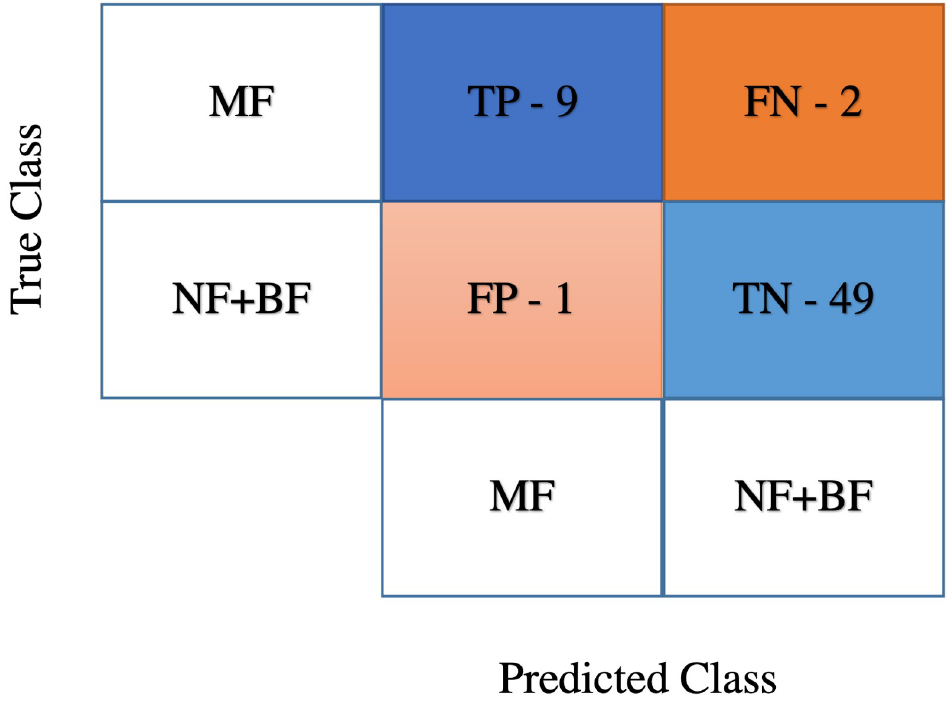
Fig 8. Confusion matrix obtained from the non-parametric thresholding